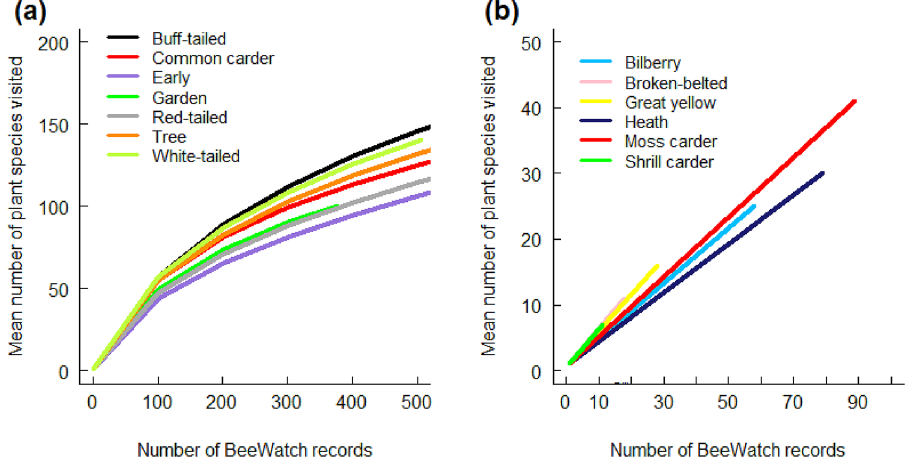
Figure 3. Estimated mean numbers of plants predicted to be visited by bumblebee species when assessing an increasingly large number of records. (a) mean number of plant species predicted to be used by each of the seven ‘common’ UK true bumblebee species; (b) mean number of plant species predicted to be used by each of six ‘rarer’ UK true bumblebee species. Results were generated using data gathered from the citizen science programme BeeWatch, where 10 plant choices were randomly sub-sampled, without replacement, using 100 repeats of the procedure. Predictions for bumblebee species which had less than 10 records, i.e. the brown- banded carder and the red-shanked carder bees and the ruderal bumblebee, were unable to be